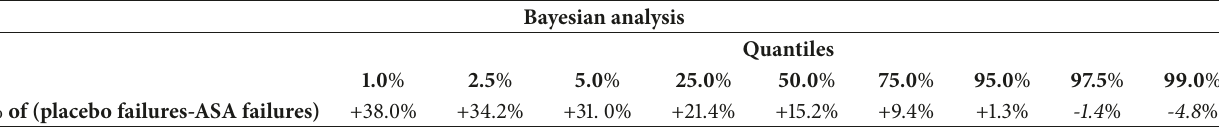
Table 7: Bayesian analysis on the primary outcome +